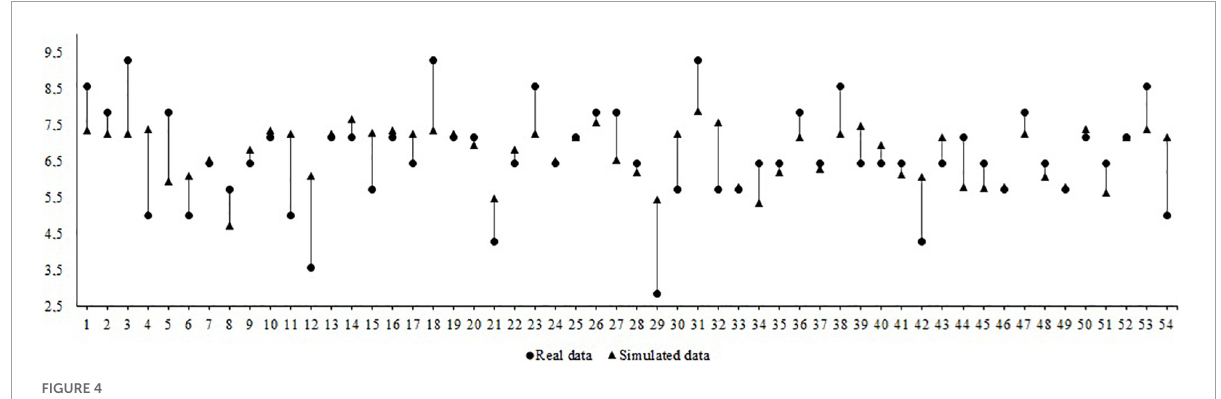
FIGURE4 Graphical validation of the model for a sample of 54